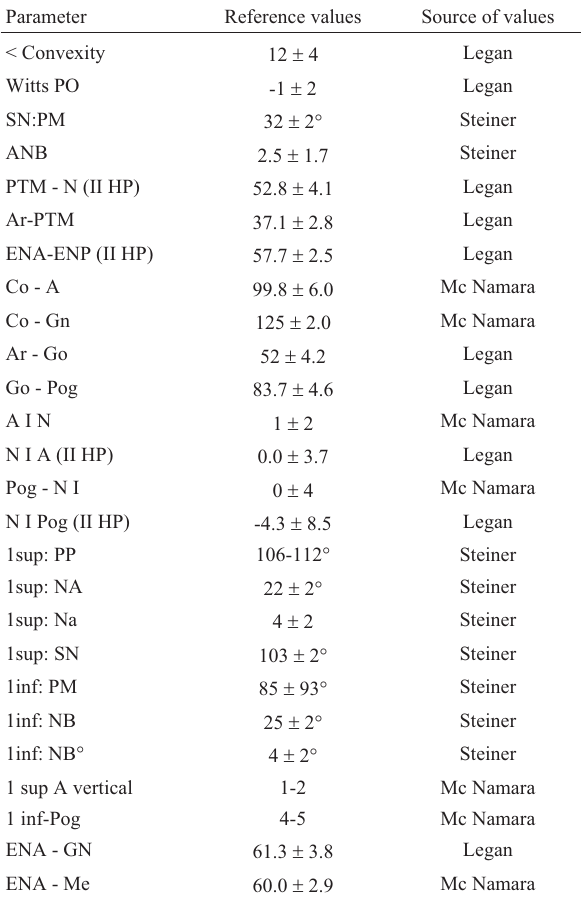
Table 2 - Reference values for measurements used in the cephalometric analysis of individuals with (n = 18) and without (n = 12) AI.